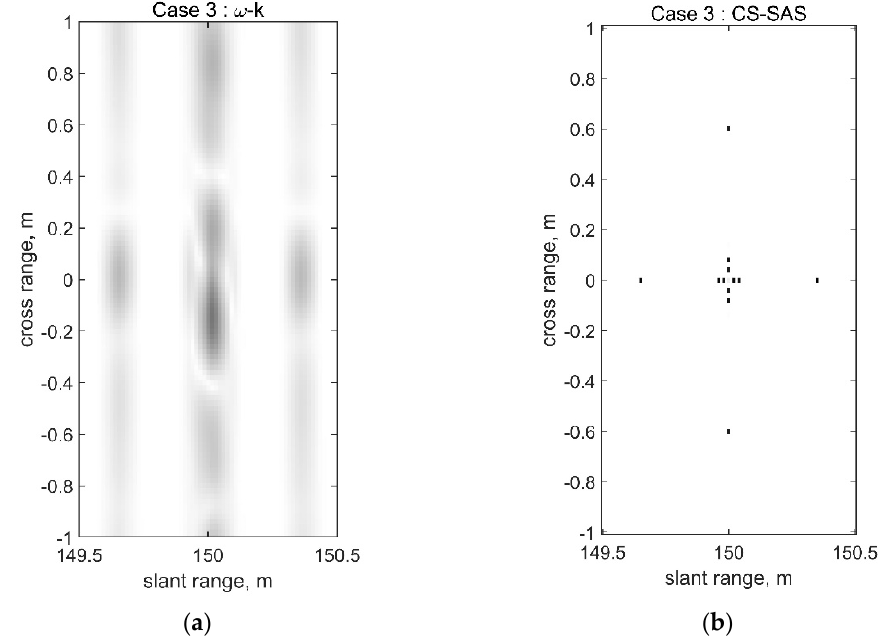
Figure 7. Simulation results for Case 3 for single sensor: ( a ) result for the ω -k algorithm; ( b ) result for the CS-SAS algorithm for single sensor.